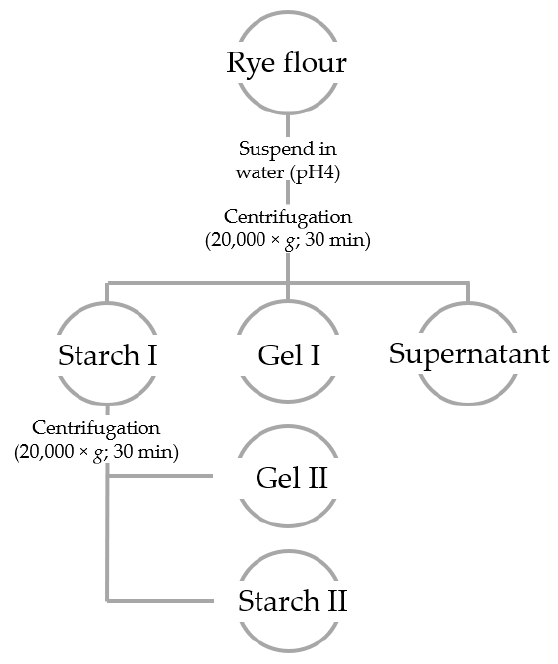
Figure 1. Separation scheme of the ingredients of rye milling products by centrifugation.